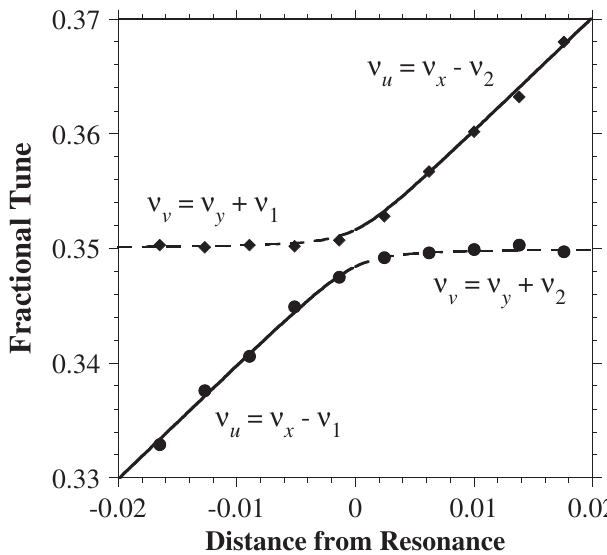
FIG. 1. Measured fractional tunes at the SPring-8 storage ring. The solid line indicated the expected horizontal tune, the dashed one corresponds to the vertical.